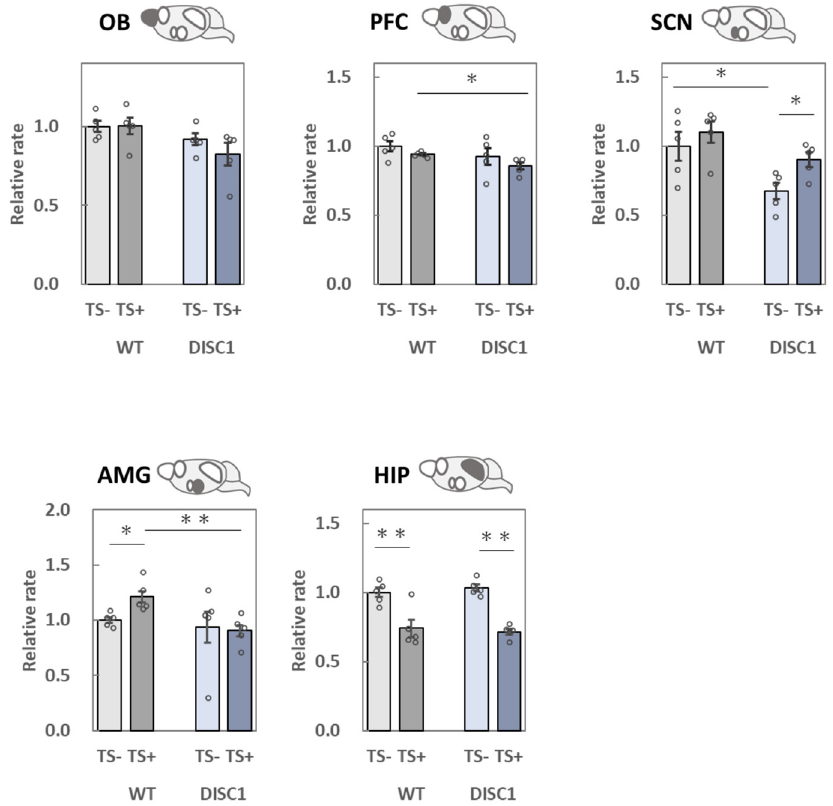
Figure 3. Measurement of the amounts of polySia by ELISA (12E3 antibody). PolySia expression levels in the five brain regions collected from the four groups of mice were analyzed. The samples were added to the wells of a 96-well plate (250 ng as protein), and the amounts of polySia were determined using the 12E3 anti-polySia antibody. The same sample was treated with endo-N, and subtraction was performed for specific polySia measurements. All data points represent averages of the three assays. The average in group 1 [WT, TS-] was set to 1. Error bars indicate the SEM ( n = 5). OB: olfactory bulb, PFC: prefrontal cortex, SCN: suprachiasmatic nucleus, AMG: amygdala, HIP: hippocampus. *: p < 0.05, **: p < 0.01.